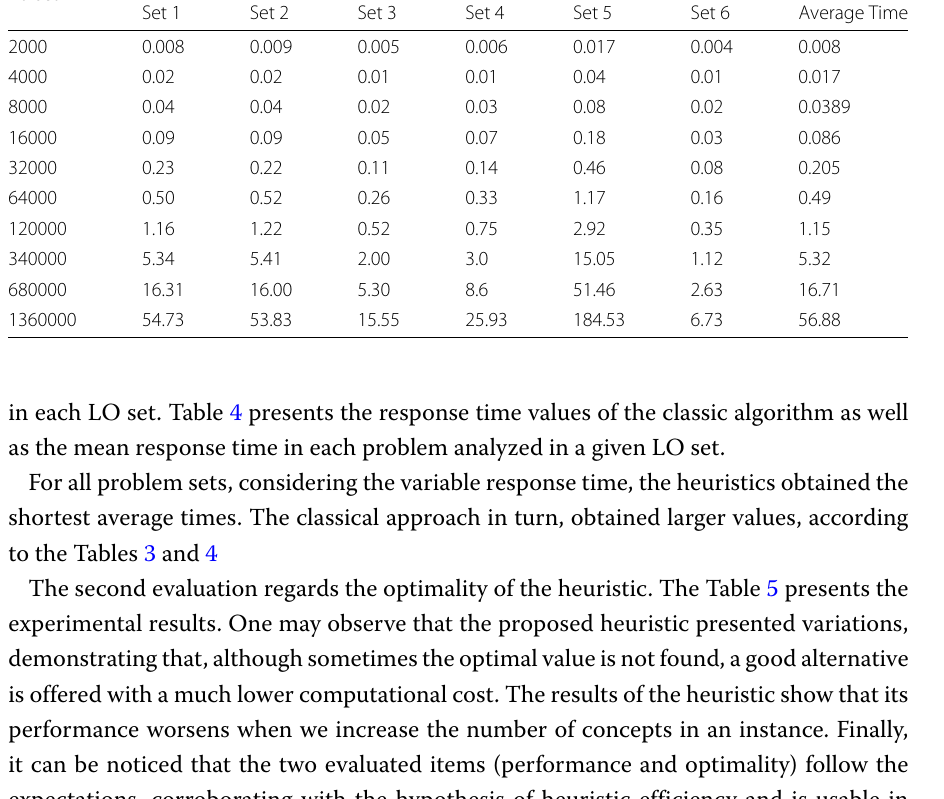
Table 3 Response time of the proposed heuristic for each set of LO LO set